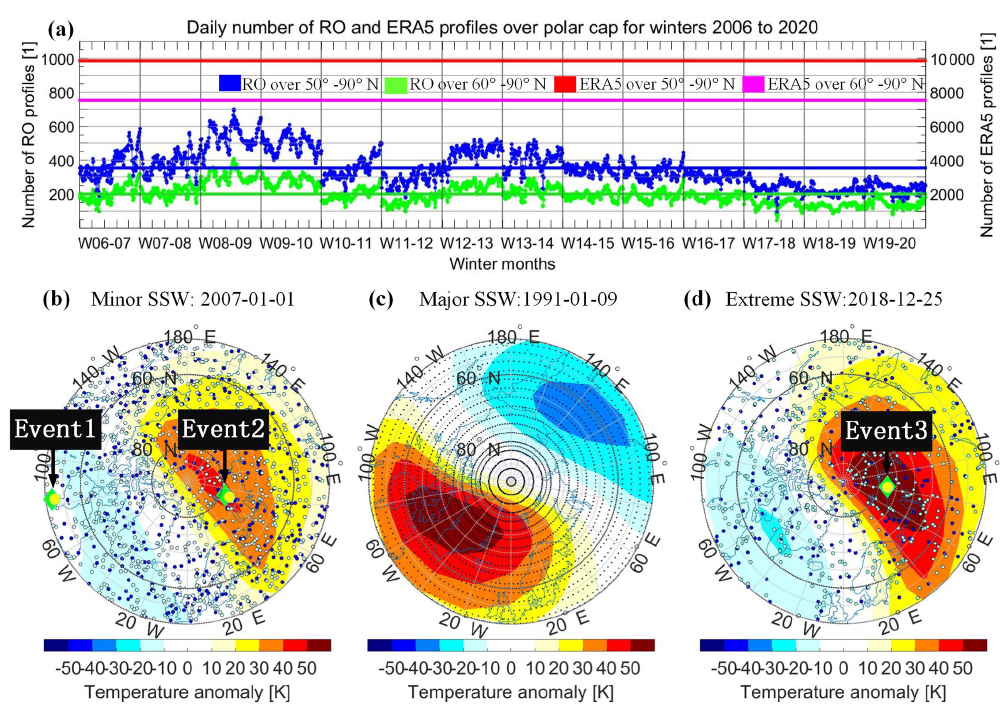
Figure 1. Number and distribution of RO and ERA5 profile data over the northern polar region. (a) Daily number of RO events over 50– 90 ◦ N (blue dots) and 60–90 ◦ N (green dots) for 14 winters from W06–07 to W19–20, with the blue and green horizontal lines showing the related long-term average number, as well as the (constant) daily number of ERA5 grid point profiles (four analysis times per grid point per day; red and magenta lines); (b) illustrative distribution of RO event locations on 1 January 2007 (blue dots) and on the previous and next days (light blue dots) over-plotted on the middle-stratosphere temperature anomaly (MSTA) of the day (color bar), on which a minor SSW prevailed; (c) distribution of the regular ERA5 grid point profile locations (2.5 ◦ latitude × 2.5 ◦ longitude grid), over-plotted on the MSTA of 9 January 1991, where a major SSW prevailed; (d) illustrative distribution of RO event locations on 25 December 2018 in the same style as in (b) , over-plotted on the MSTA of the day, on which an extreme SSW prevailed. The green diamonds and yellow circles in (b) and (d) show the location of three exemplary RO events and ERA5 profiles (Event1 to Event3) that are located in different SSW anomaly strength conditions and are used in Fig. 2 to illustrate the anomalies construction